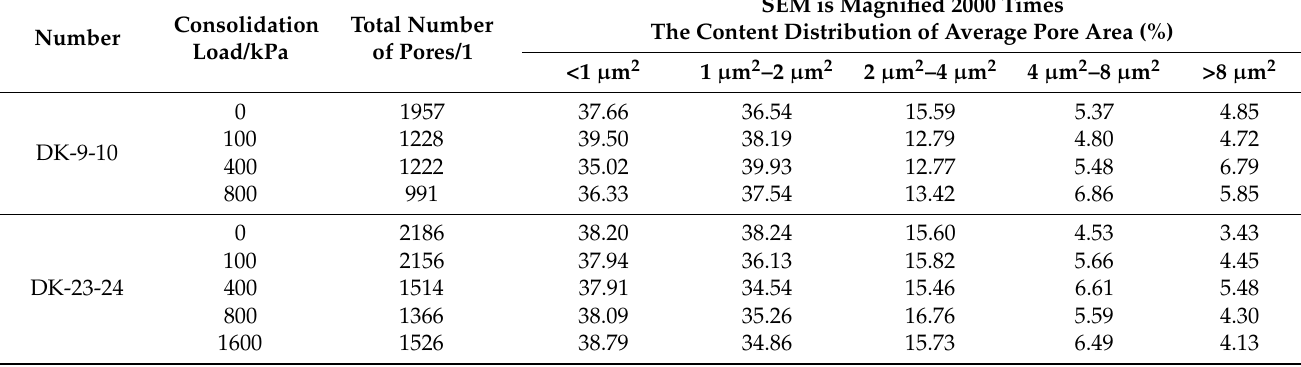
Table 3. Pore distribution under different consolidation loads (2000-times